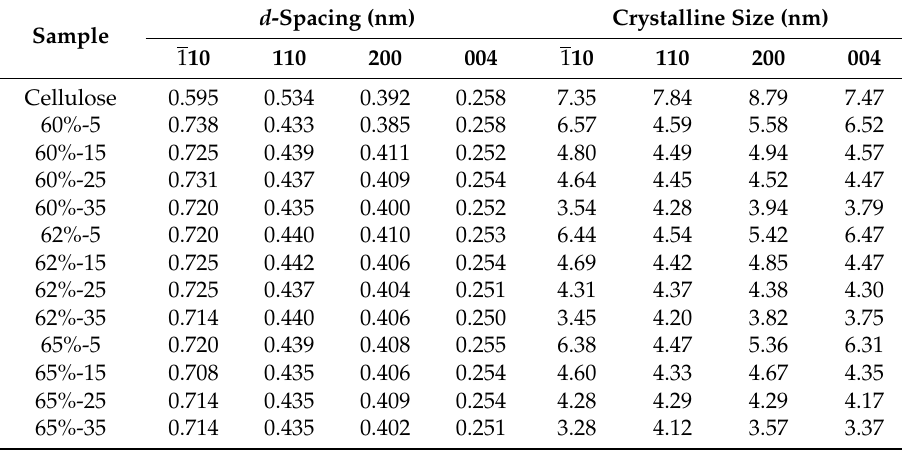
Table 1. The d -spacings and the crystalline size of cellulose samples.